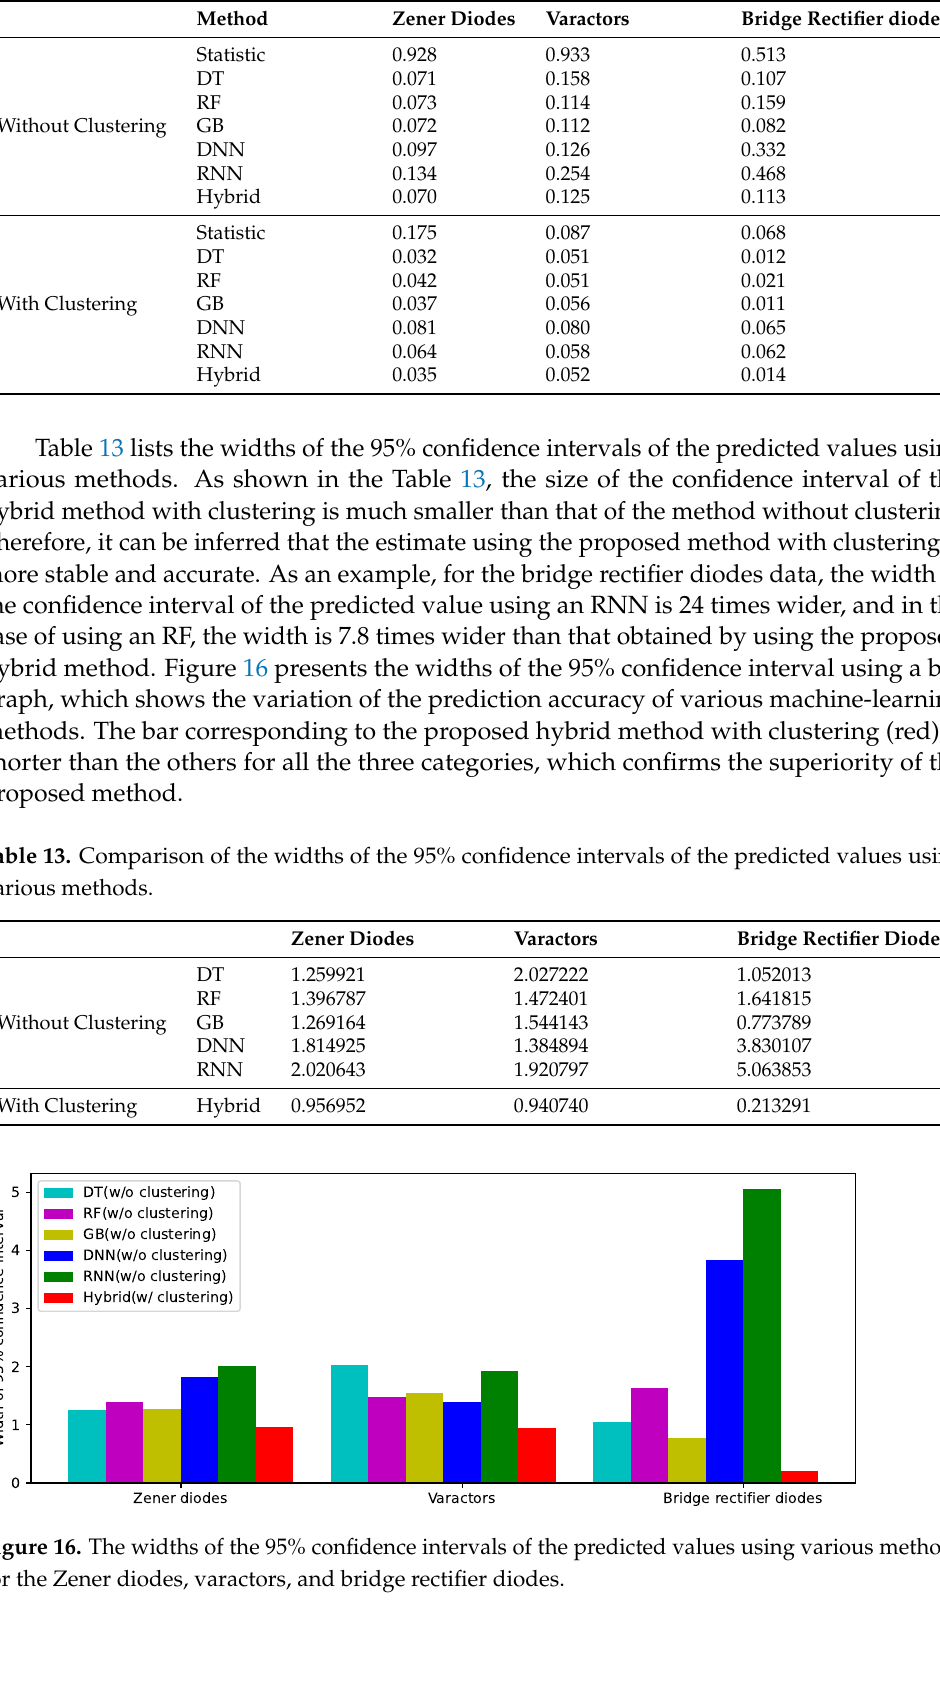
Table 12. MRE of the test data with and without clustering.